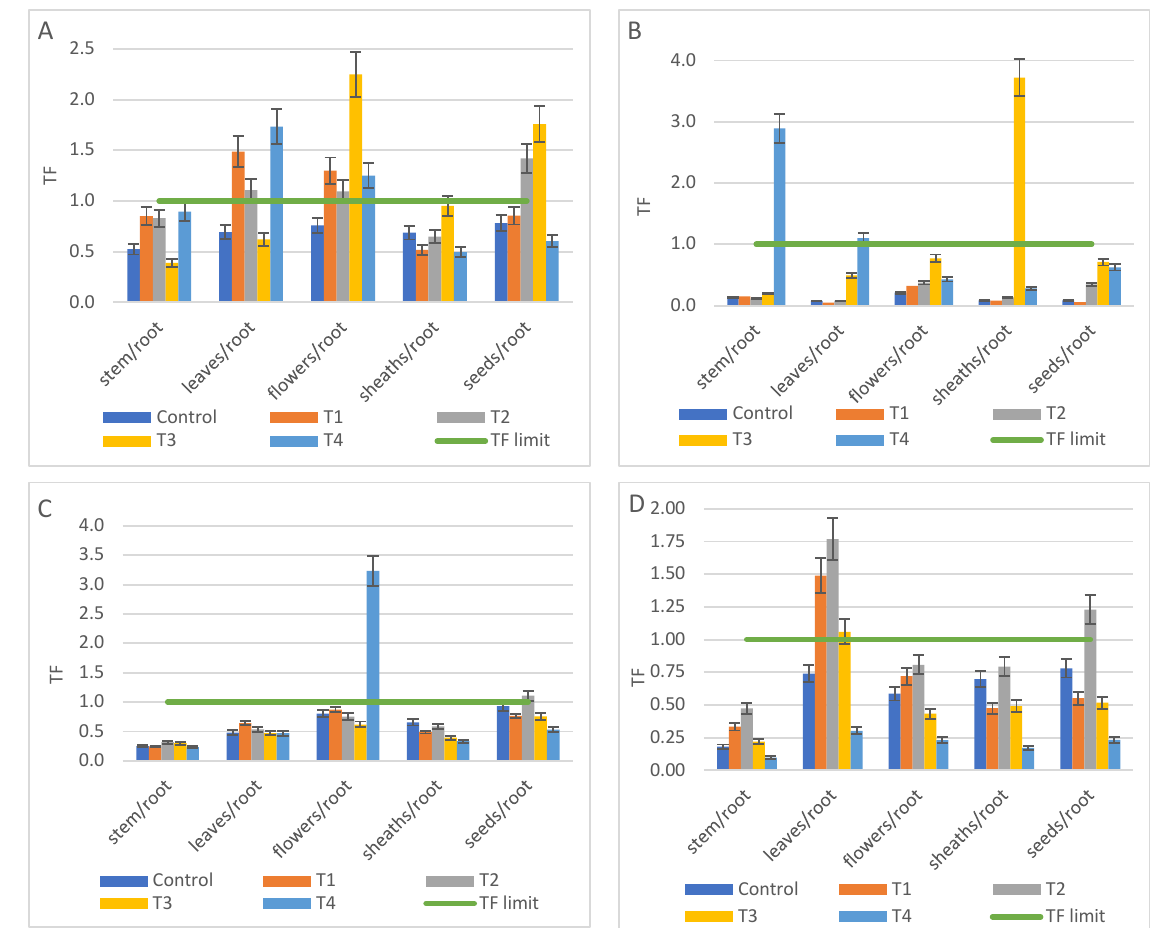
Figure 6. The translocation factor (TF) from root of S. alba to plant tissues in T1 to T4 treatments compared with control and TF limit (average ± SD, n = 6) for micronutrients: ( A ) Zn; ( B ) Cr; ( C ) Cu; ( D ) Mn .